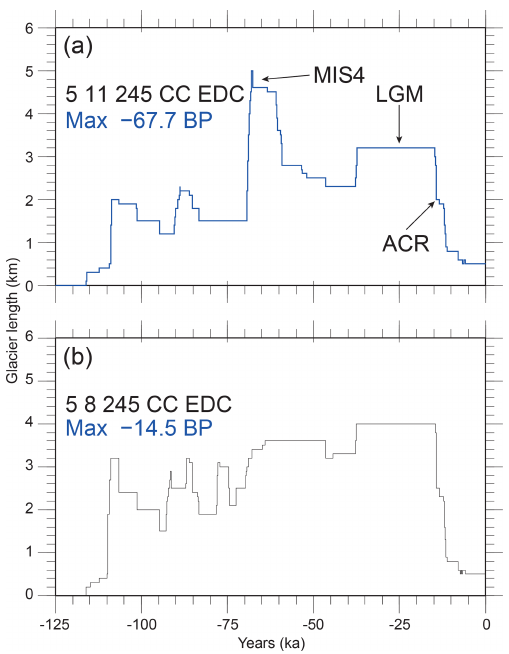
Figure 8. (a) Model output showing best fit of glacial extent to palaeoclimatic and geomorphological data, with mean annual air temperature depression of 5 ◦ C, seasonality range of 11 ◦ C, and temperature-coupled precipitation regime; forced using the EPICA Dome C temperature data. Marine Isotope Stage 4, Last Glacial Maximum, and Antarctic Cold Reversal are labelled. (b) Model output with identical climatic parameters to (a) except seasonality, which is 8 ◦